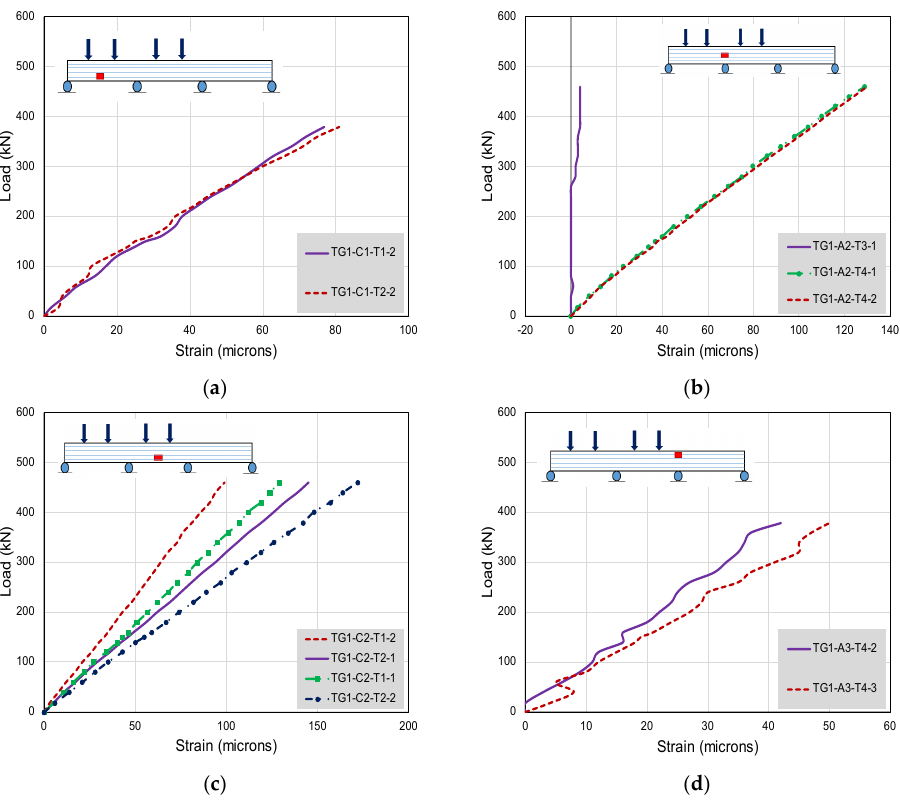
Figure 40. Tendon strains recorded during loading setup SP-1-L03 at locations ( a ) C1, ( b ) A2, ( c ) C2, and ( d ) A3. Loading Setup SP-1-L04 This loading setup corresponds to the application of four-point ultimate loading on specimen SP-1. It can be seen from Figure 41 that tendons did not yield at locations C1, C2, and A3. Tendon strains more than their yield strains were only recorded at the left interior support, with a magnitude of approximately 4000 microns.